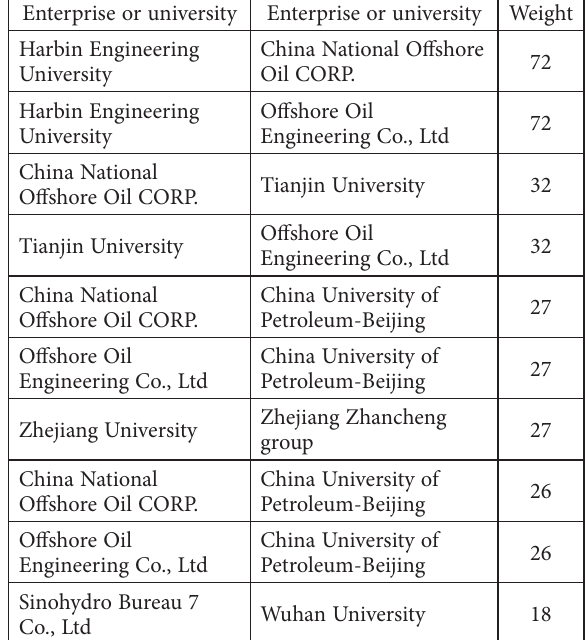
Table 7. Top 10 most closely linked enterprises and